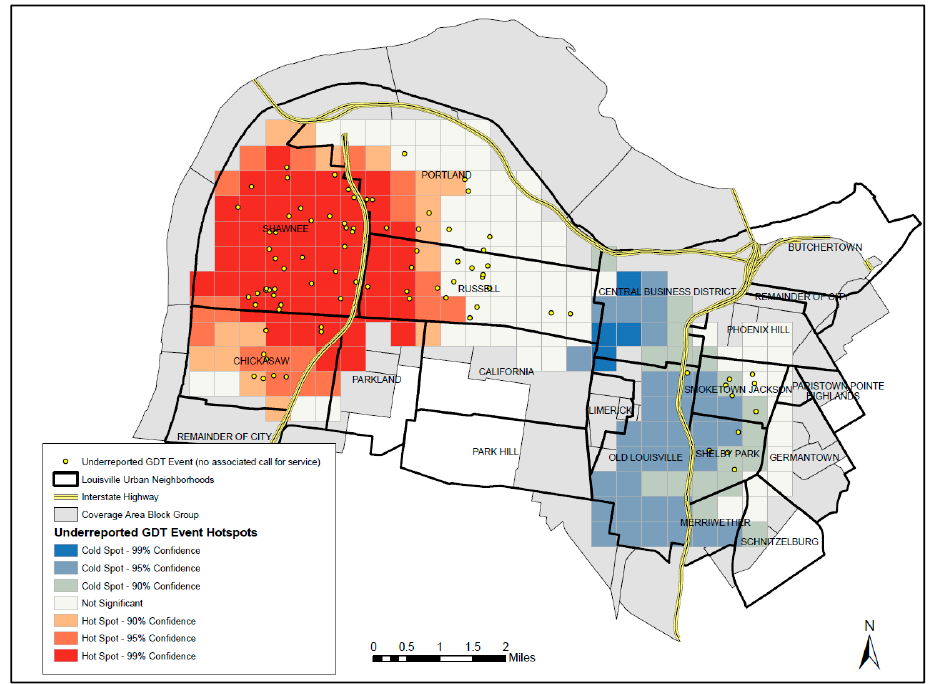
Figure 5. Hot spot analysis for underreported GDT events. Table 3. Observed gunshots over mean expected frequencies using spatiotemporal bandwidths.